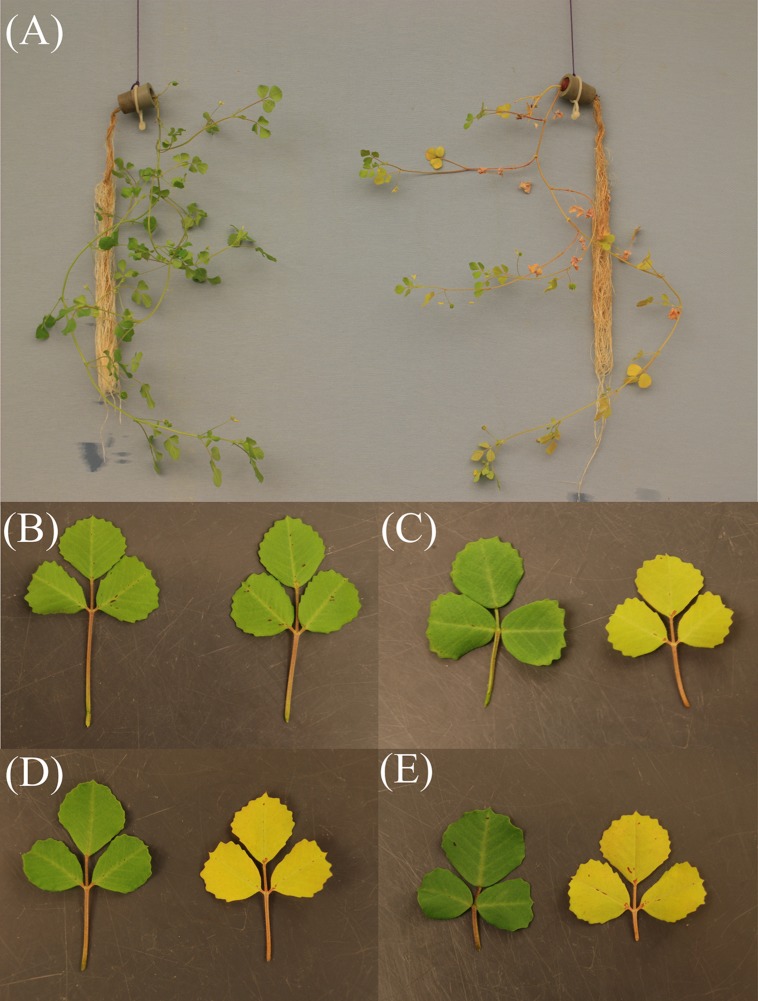
Growth of a Tnt1-Mt-mutant carrying an insert in the cds of Medtr1g084050 (nicotianamine synthase-like protein). Three-week old nodulated plants of the mutant were transferred to glass tubes with N-free nutrient solution. The plants received a low (0.25 mM) ammonium start-N supply during the first week of growth in the tubes and relied exclusively on N2 fixation for the next 7 days. During the subsequent 2 weeks, for one set of plants the nutrient solution was adjusted once a week to 5 mM nitrate concentration, while the other plants relied solely on nitrogen fixation. (A) Shows nitrate (left) and N2-supplied (right) plants at the end of the growth period. (B–E) Show fully expanded leaves of nitrogen fixation (right) or nitrate-dependent (left) plants 0, 7, 10, and 14 days after the beginning of the nitrate supply.